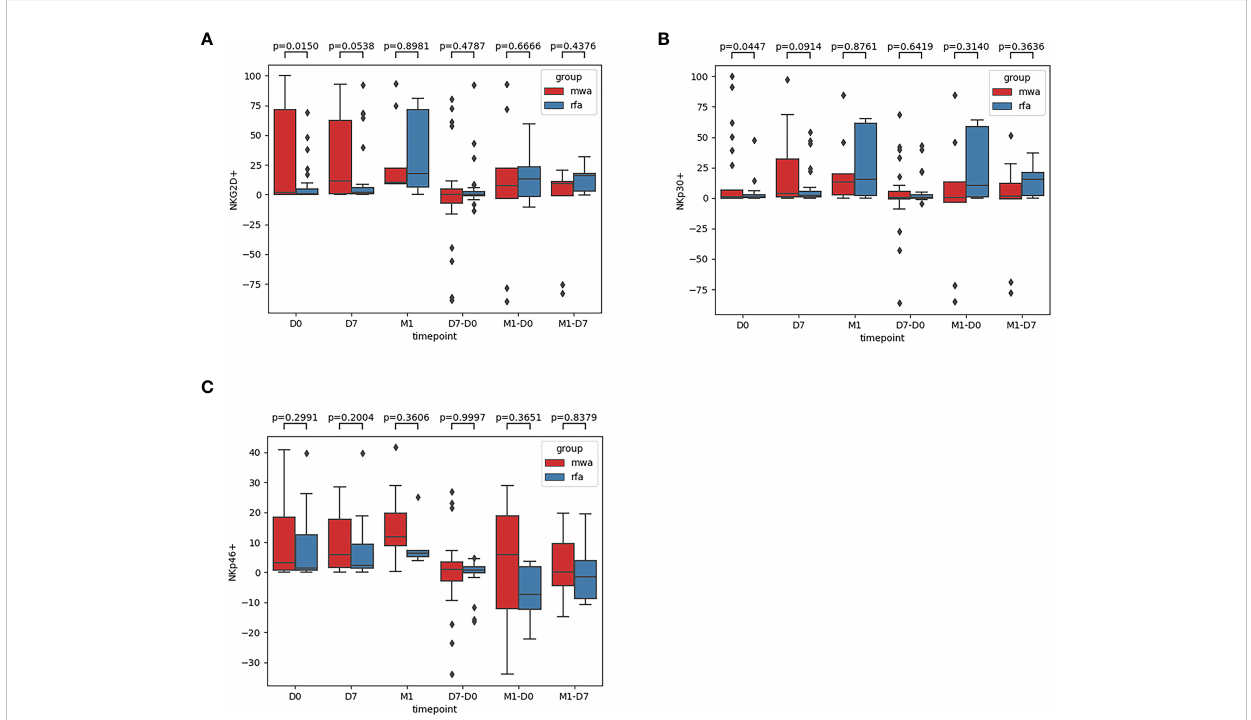
FIGURE 3 The frequencies of activated receptors NKG2D (A) , NKp30 (B) , and NKp46 (C) in the WMA group and RFA group were compared . The frequencies of activated receptors (NKG2D, NKp30, and NKp46) in D0(P=0.015, P=0.045, P=0.299), D7 (P= 0.054, P=0.091, P=0.2), M1 (P= 0.90, P=0.88, P=0.36), D7-D0 (P=0.48, P=0.64, P=0.99), M1-D0 (P=0.67, P=0.31, P=0.37), M1-D7 (P=0.44, P=0.36, P=0.84), indicating that in D0, There were differences in NK cell activation receptor NKG2D (P<0.05) (A) and NK cell activation receptor NKp30(P<0.05) (B) . At D7 NKG2D(P=0.054) (A)